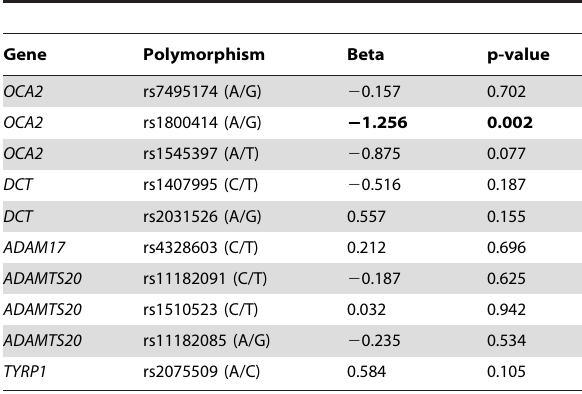
Table 3. Linear regression coefficients and p-values for each of the 10 SNPs in the Canadian East Asian